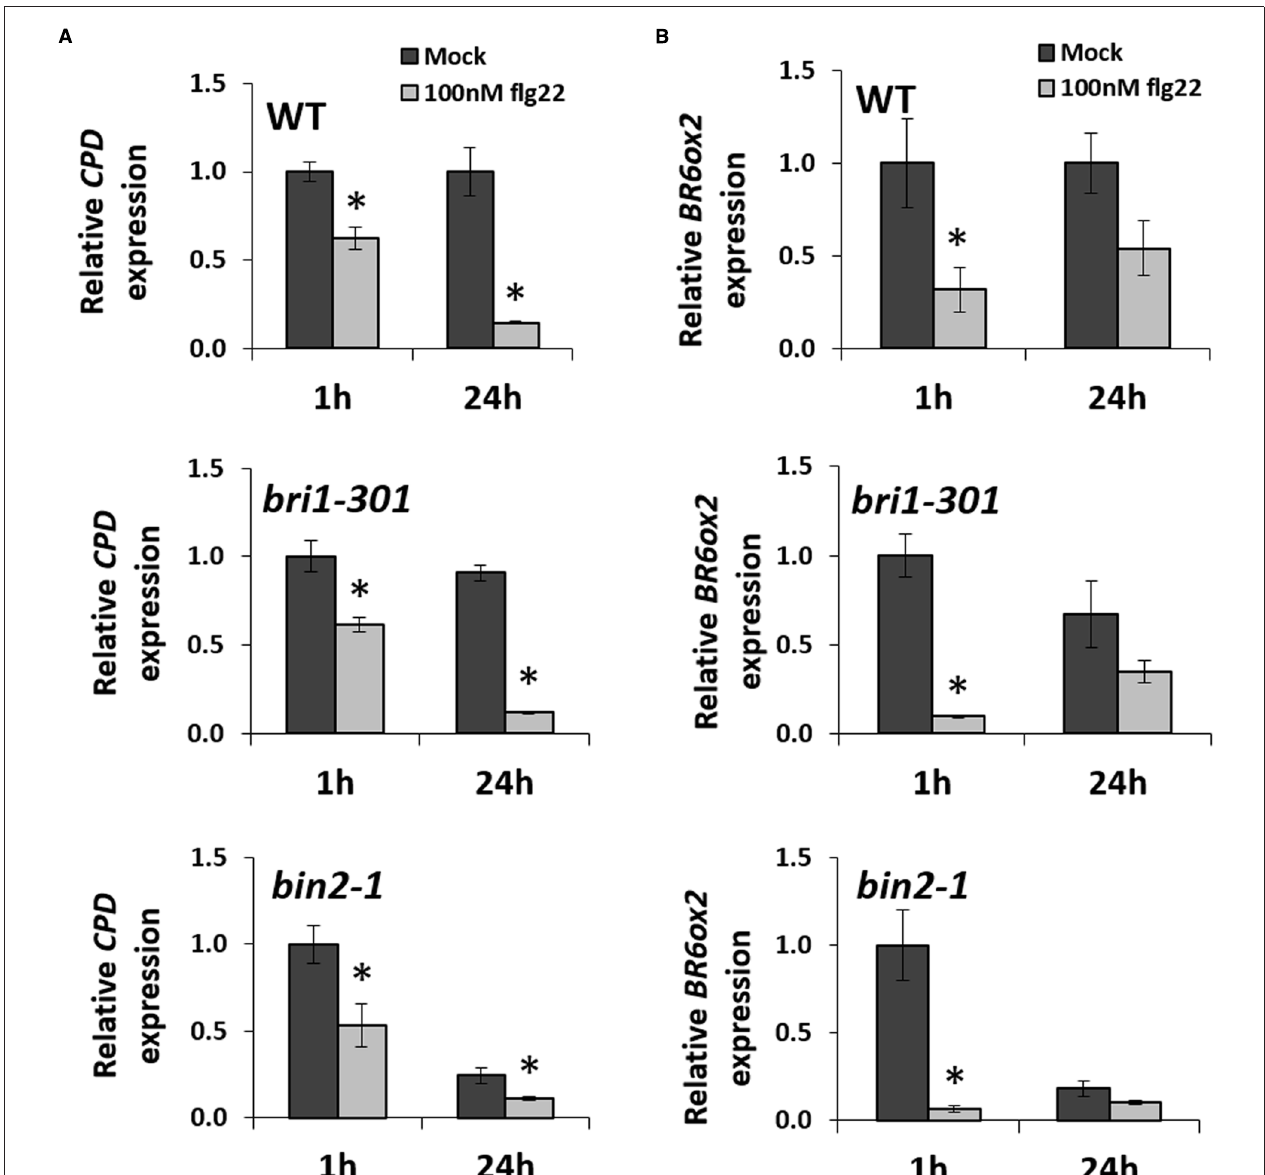
FIGURE 2 | The flg22-triggered repression of BR biosynthetic genes does not require BR perception or signaling. Relative expression of the BR biosynthetic genes CPD (A) and BR6ox2 (B) in Arabidopsis Col-0 wild-type (WT) and the BR signaling mutants bri1-301 and bin2-1 , following treatment with flg22, as measured by qPCR. Ten-day-old seedlings were submerged in a 100 nM flg22 or mock solution for 1 or 24 h. Bars represent standard deviation, with n = 3. Asterisks indicate a statistically significant difference, according to a Student’s t -test, with p < 0.05. This experiment was repeated three times with similar results; values from one representative experiment are